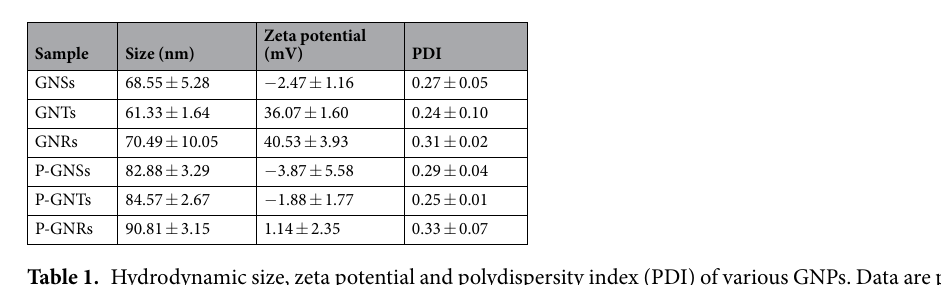
Three anisotropic gold nanoparticles: stars, rods, and triangles were synthesized and coated with mPEG and used to investigate the effect of shape on cellular uptake. The mean size of GNPs measured by TEM was ~50 nm